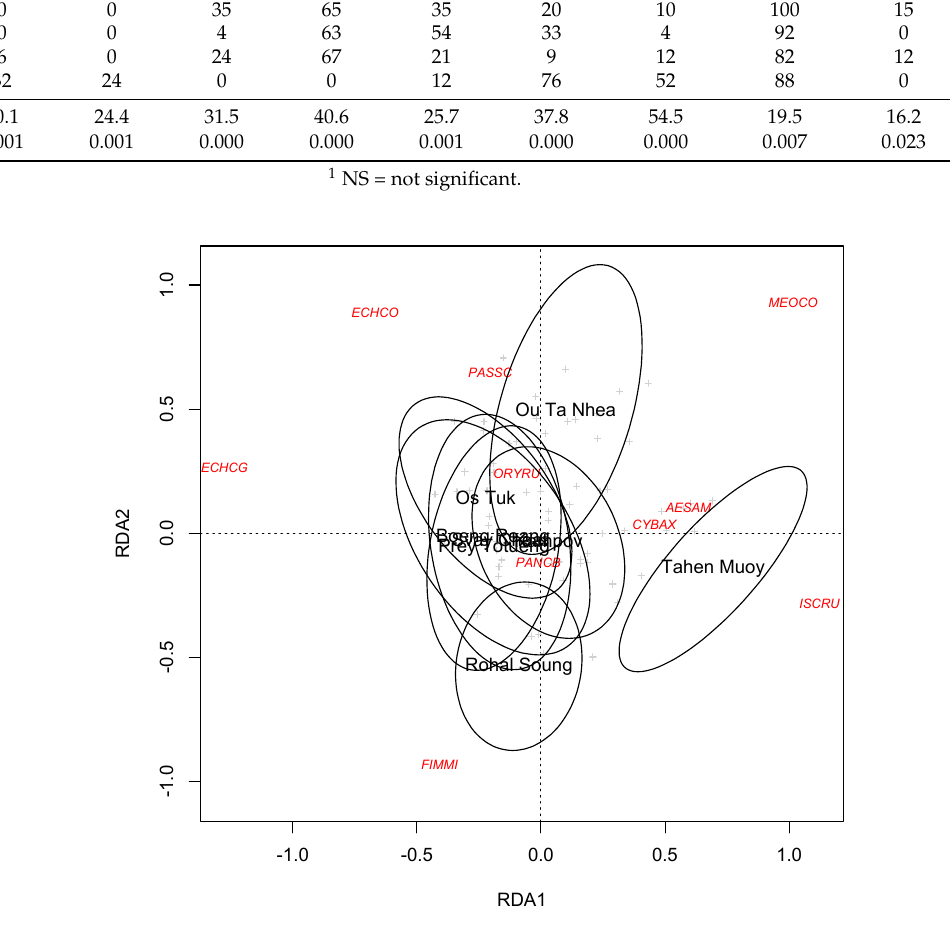
Figure 2. Redundancy analysis (RDA) of weed species diversity of contaminants in paddy seed samples. Frequencies of weed seed contaminants in paddy (Table 10, Figure 2) differed from